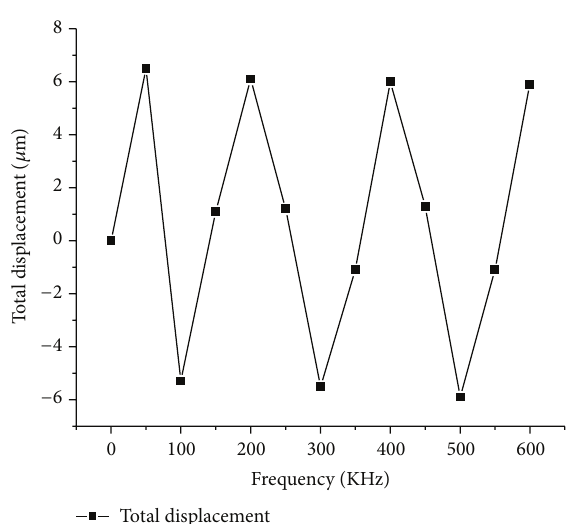
Figure 8: Plot of change in displacement with respect to frequency.